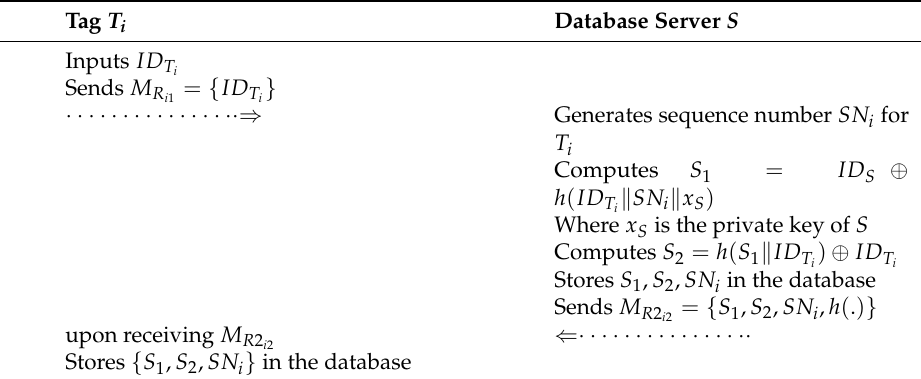
Table 4. Registration phase of RFID tag.